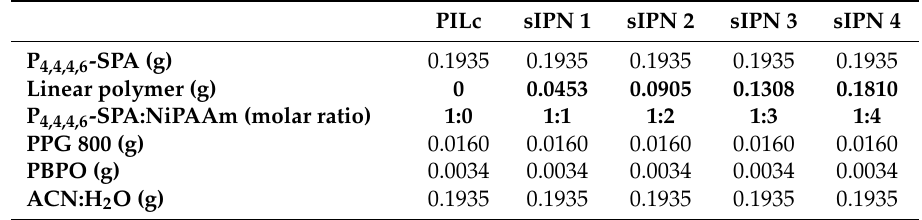
Table 1. Monomeric mixture compositions for the synthesized